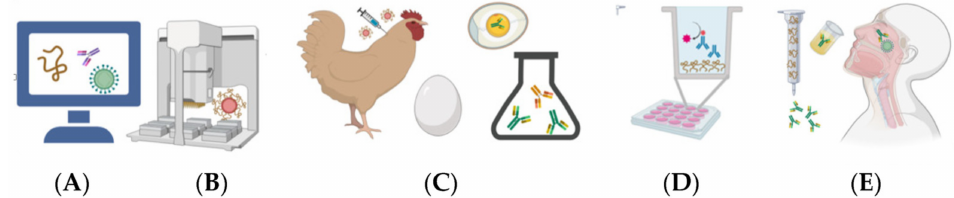
Figure 3. Steps for the development of an oral-based therapeutic: ( A ) epitope analysis; ( B ) peptide synthesis coupled to a carrier protein; ( C ) hens immunization and antibody collection; ( D ) immunoassay for a screening of specificity; and ( E ) enrichment and final development of an oral-based therapeutic gargle. Created with